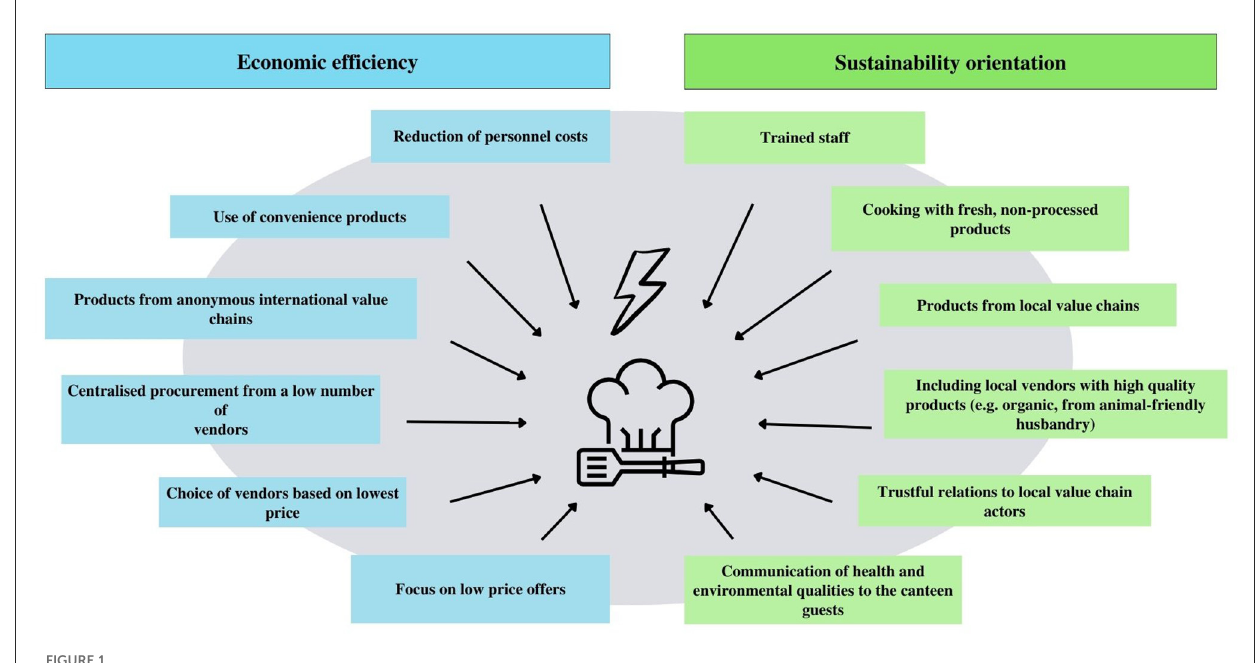
FIGURE1 Tension between economic efficiency and sustainability